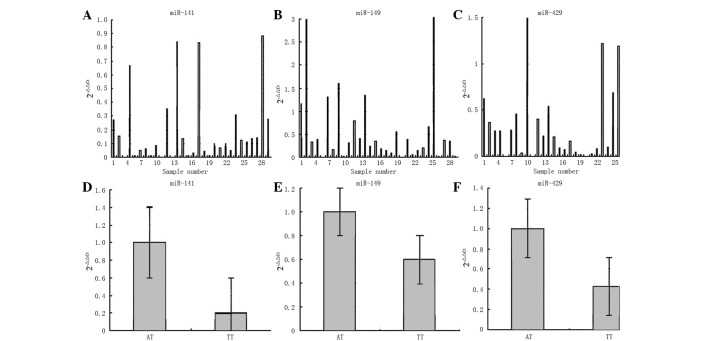
Individual (A, B, C) and general (D, E, F) relative quantification for miR-141, miR-149 and miR-429 in tissue samples from patients with clear cell renal cell carcinoma (ccRCC). AT, adjacent tissue; TT, tumor tissue.